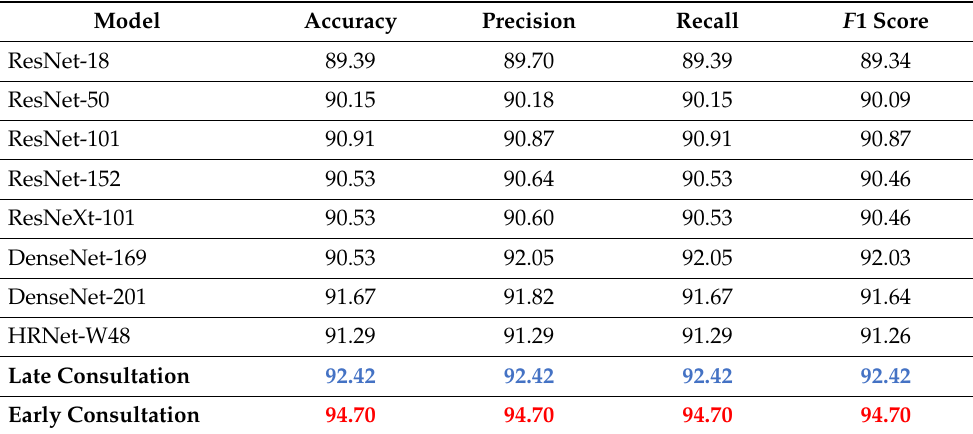
Table 4. Ablation study on the UIT COVID-19 dataset [39]. The performance of individual doctor models and two implementations of doctor consultation-inspired models. The top-two methods are marked in red and blue ,